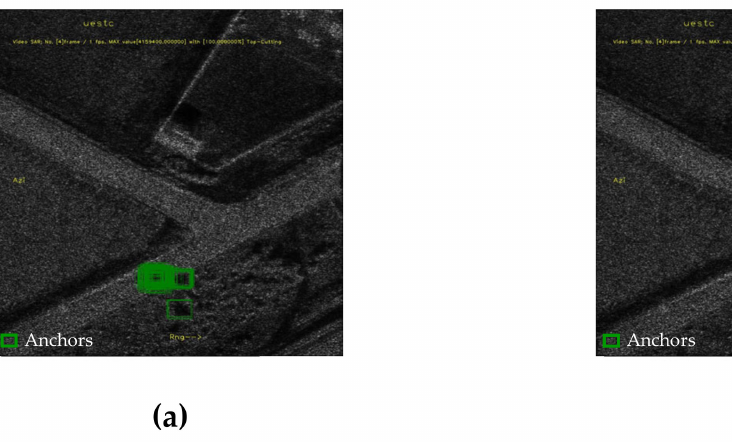
Figure 26. Ablation experiment on GA-SubNet: ( a ) Siamese-RPN; ( b ) GASN. Figure 11. Polypseudorotaxanes inter- or intra-crosslink with each other via hydrogen bonding. Table 8. Ablation experiment of GA-SubNet. Table 2. Ten percent 10KPEGMA and 10% P-10K solutions with 10% α -CD.